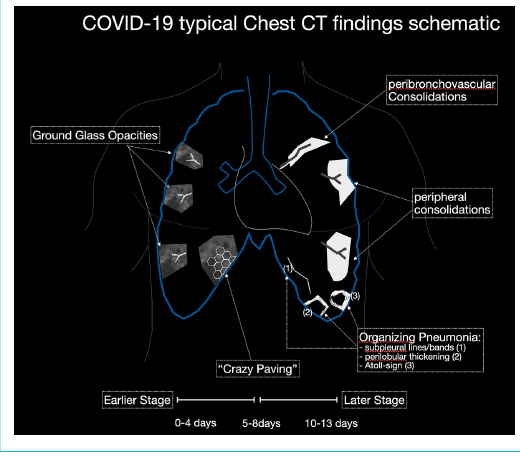
Figure 5: Schematic depiction of typical chest computed tomogra- phy (CT) findings for COVID-19: bilateral, focal ground glass opac- ities or consolidations with peripheral and basal distribution. Ground glass opacities – predominantly seen at earlier stages of infection – are gradually replaced by consolidations during pro- gression of the disease. With progression repair mechanisms with an organising pneumonia pattern become evident, with particular CT signs, such as subpleural lines/bands, perilobular thickening or formation of atoll signs. Another unique pattern seen with disease progression is the “crazy paving” sign, a combination of ground glass opacities and thickened interstitial lines in a mosaic pattern of irregular paving stones.